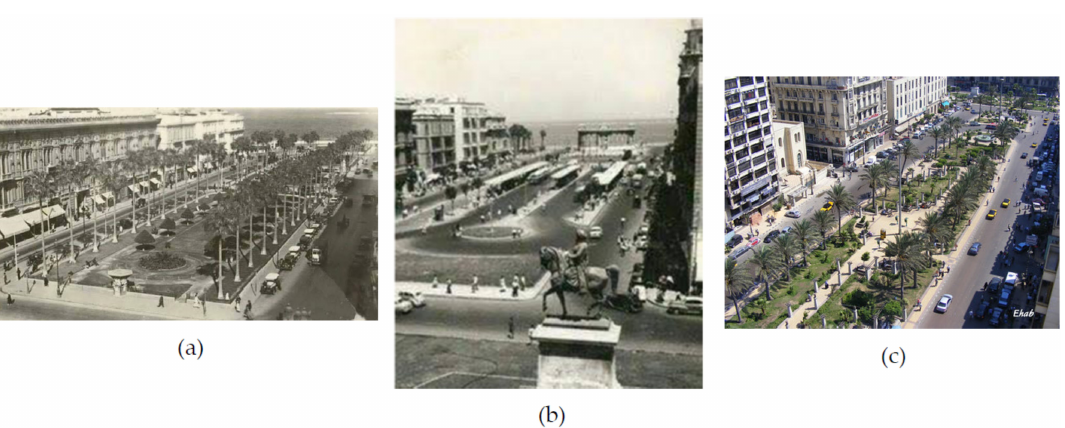
Figure 3. Three photos for Orabi Square among di ff erent historical periods, showing the changed plan. ( a ) French Gardens 1930s. Source: [27]. ( b ) Orabi Square 1950s tram and bus station. Source: [28] ( c ) Orabi Square plan now. Source: F. Hussein.